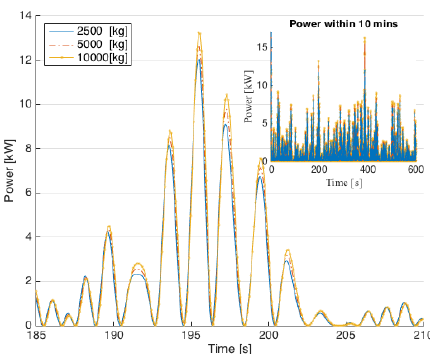
Figure 8. Instantaneous power output with different cases of translator mass under an identical sea state (3.5 s, 0.75 m). The main plot gives the comparative results in a time span of 25 s, while the sub-plot gives an overview of the results in 10 min.